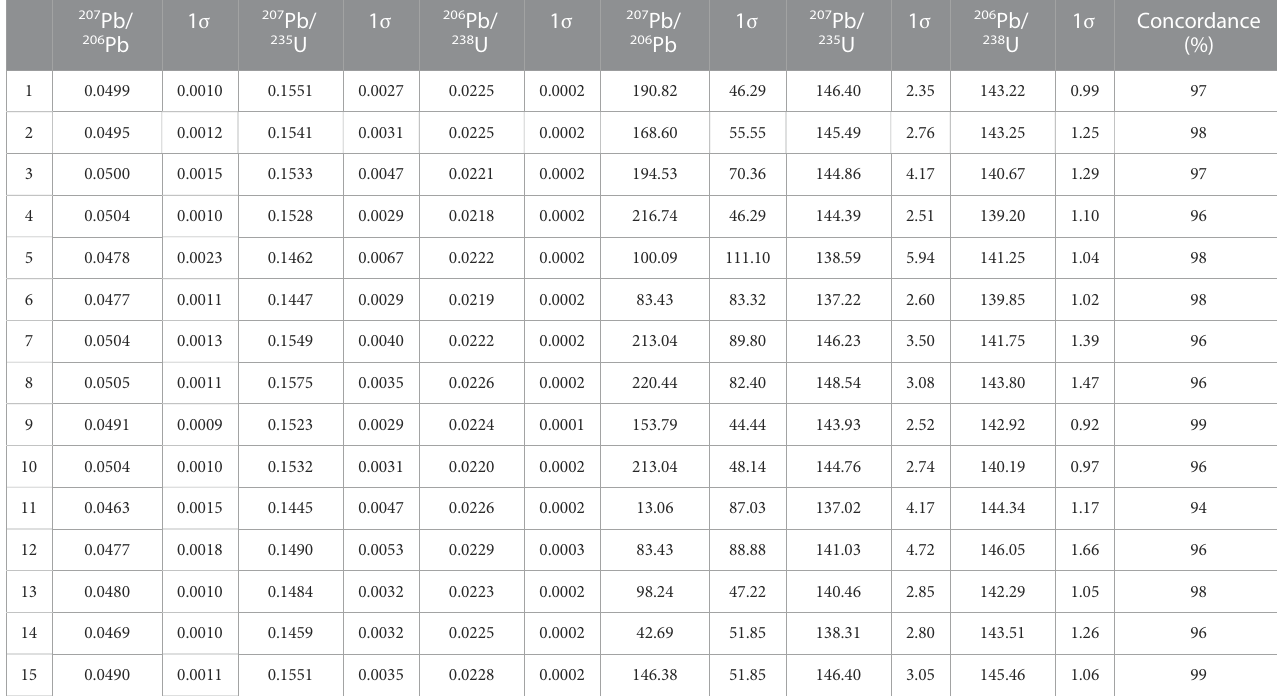
TABLE 2 LA-ICPMS U – Pb isotopic ratios and ages of the zircons from